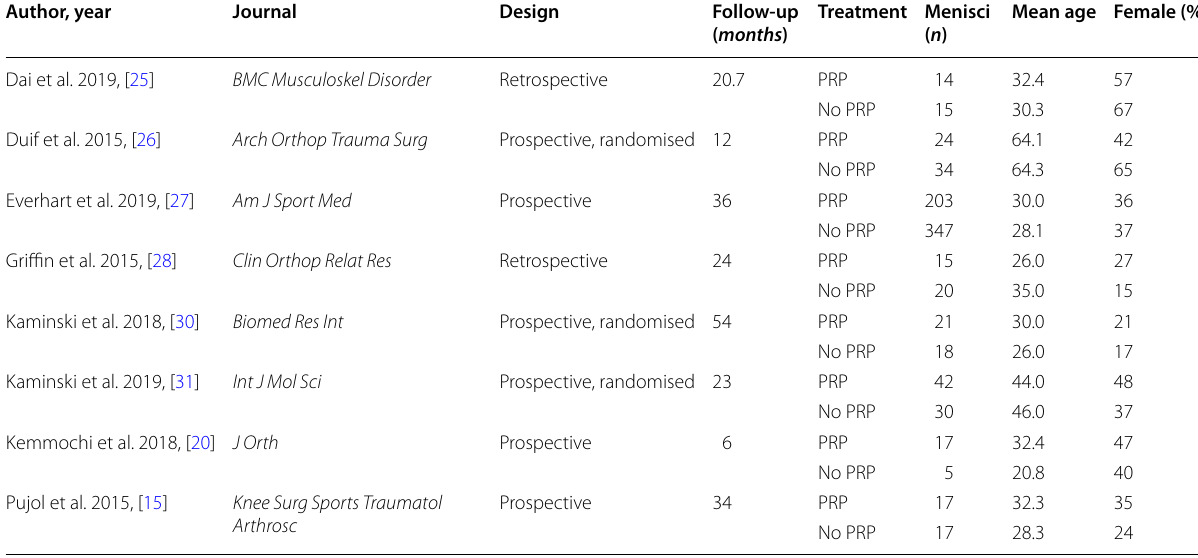
Table 1 Generalities and patient baseline data of the included studies Author,